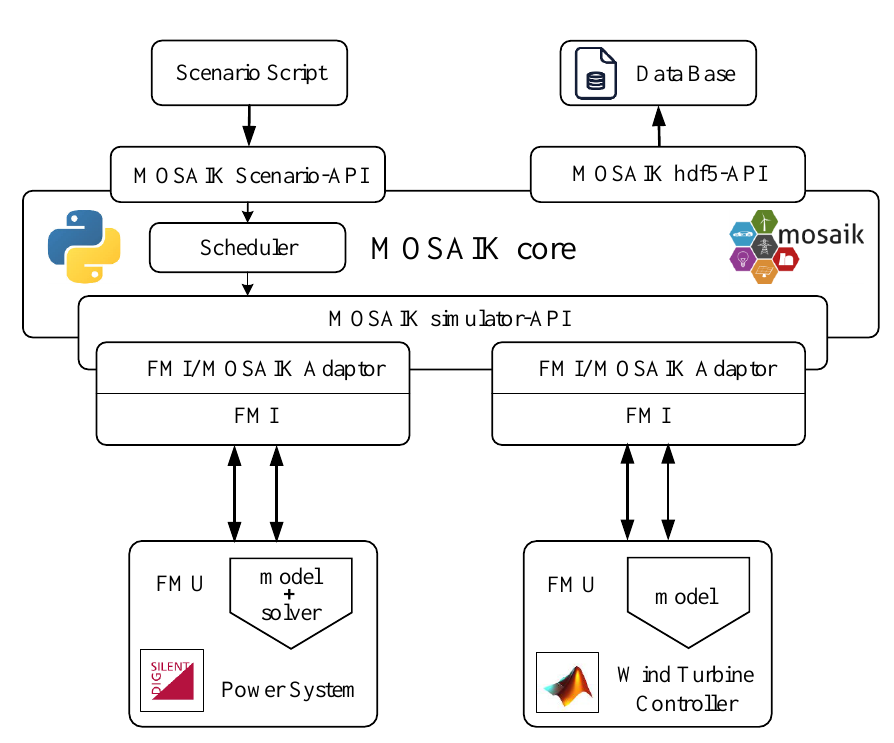
Figure 7. The MOSAIK co-simulation